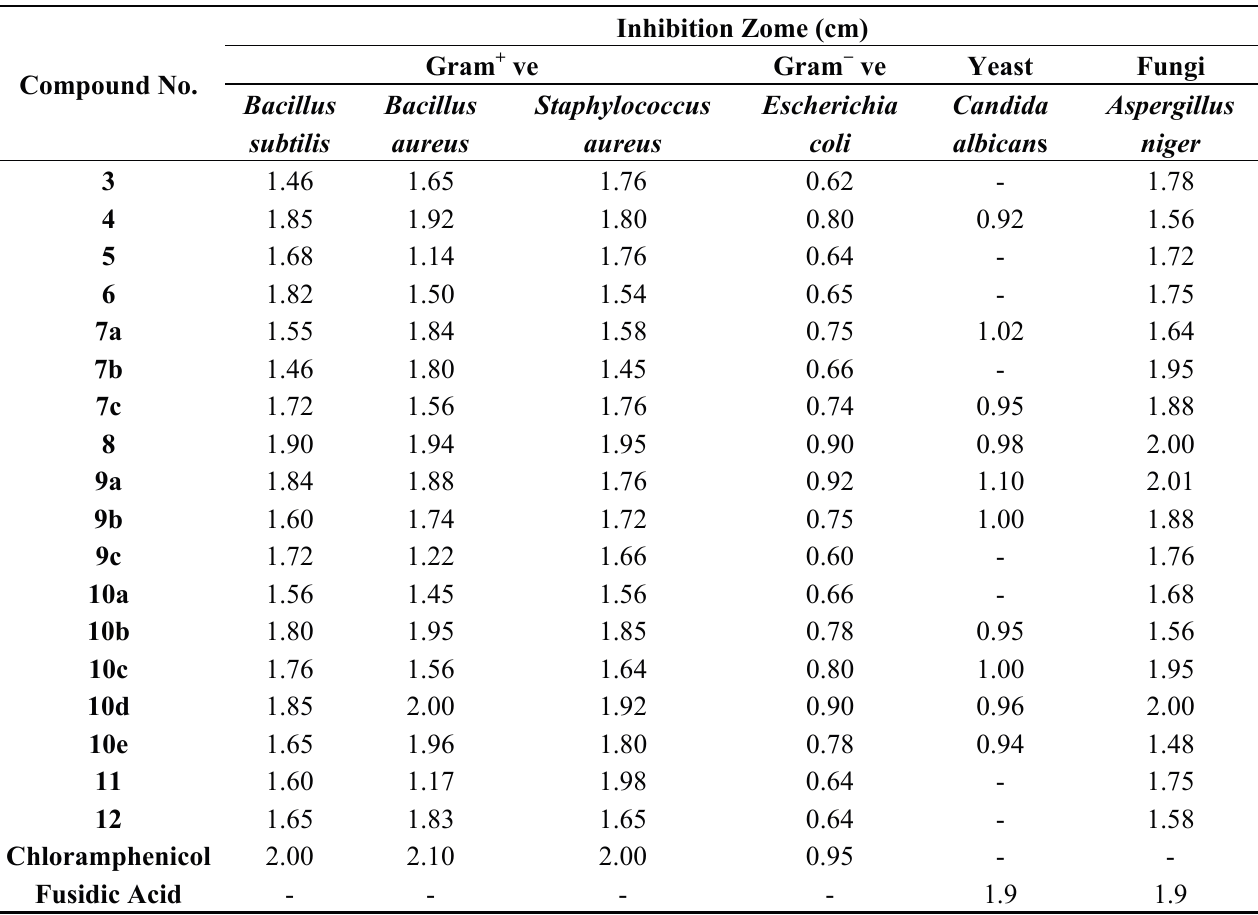
Table 1. Antimicrobial activities of some newly synthesized compounds.